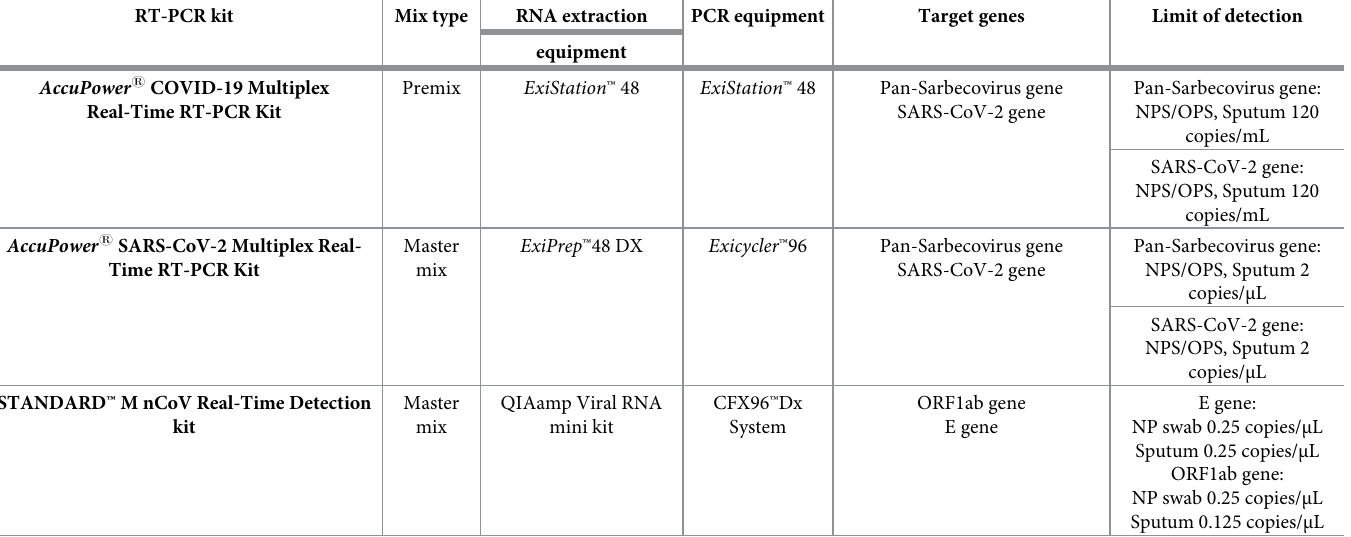
Table 2. Characteristic and PCR condition for LoD test of the AccuPower 1 kits. RT-PCR